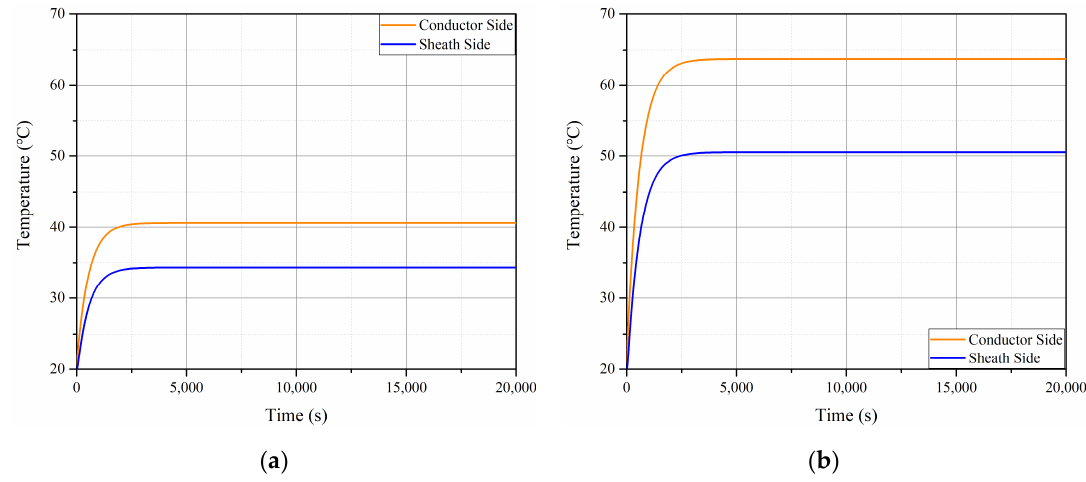
Figure 4. Time-varying temperature of the cable conductor and sheath according to the applied current: ( a ) 250 A; ( b ) 350 A.